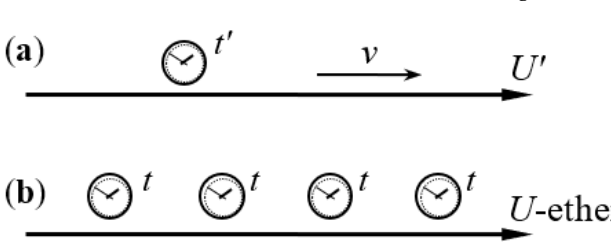
Figure 3. Comparison of time elapse: ( a ) clock moving in relation to ether; ( b ) motionless clocks in relation to ether.